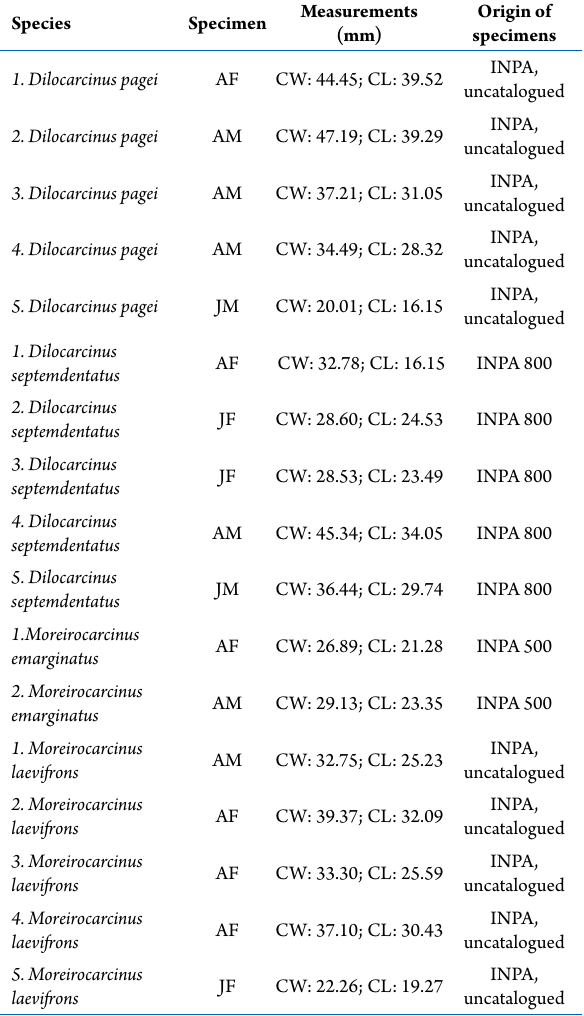
Table 1. Species of Trichodactylidae, examined specimen (sex: AF, adult female; JF, juvenile female; AM, adult male; JM, juvenile male), measurements (CW, carapace width; CL, carapace length), and origin of the specimens (INPA, crustacean collection of the Instituto Nacional de Pesquisas da Amazônia).